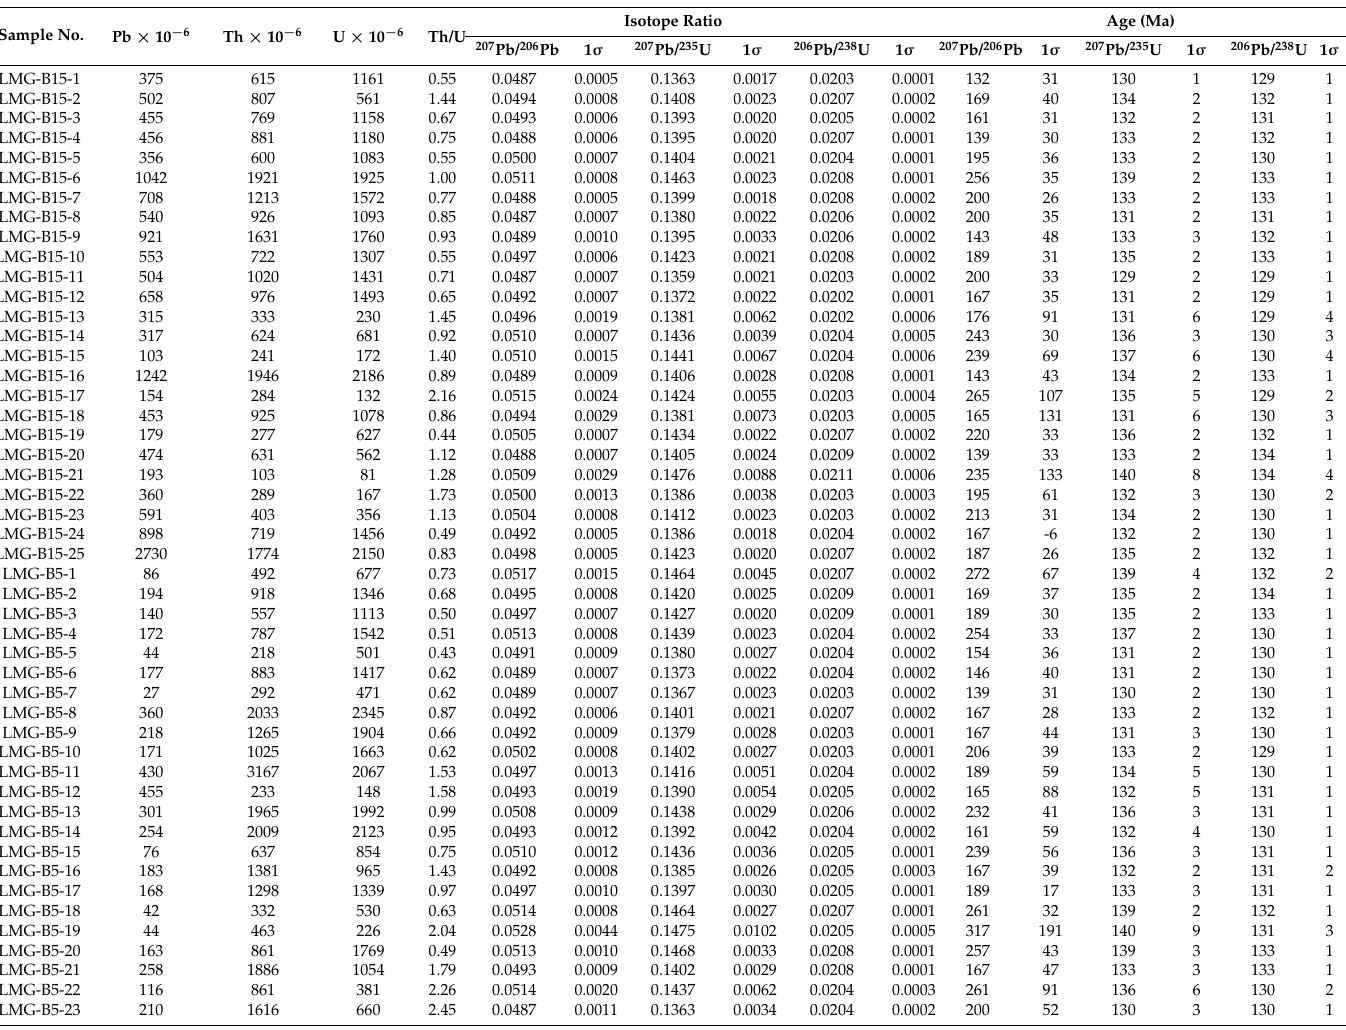
Table 1. LA-(MC)-ICP-MS zircon U–Pb data of the Leimengou granite porphyry (LMG-B15) and monzonitic granite porphyry (LMG-B5). Sample